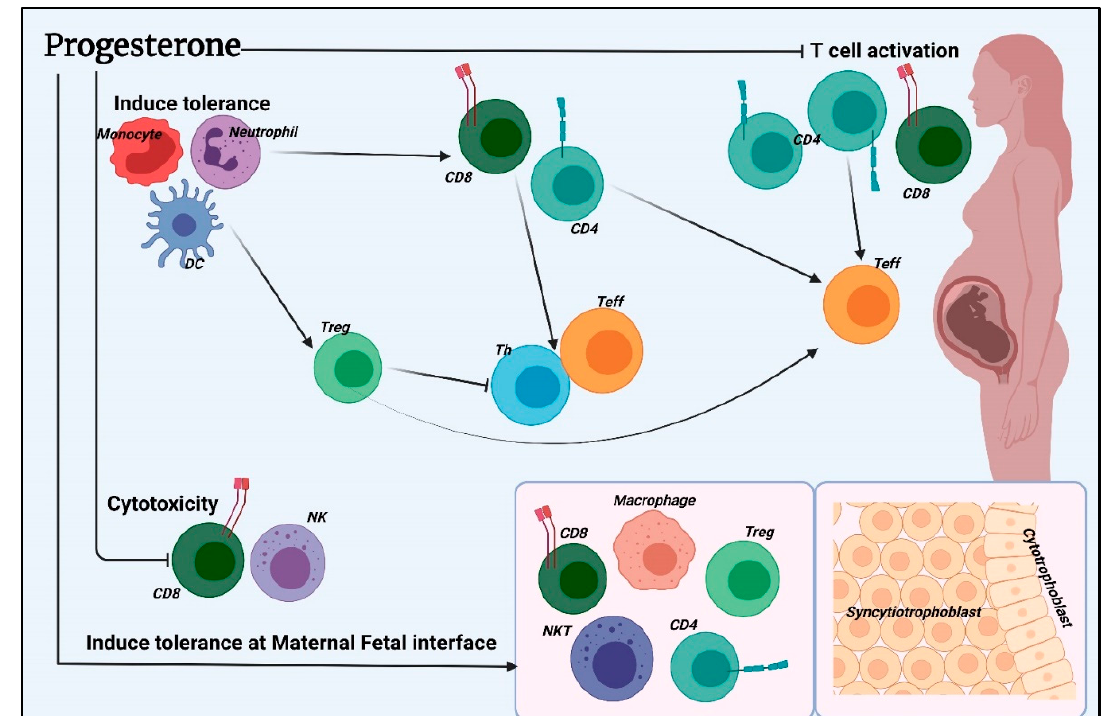
Figure 1. Summary of progesterone immunomodulatory mechanism. P4 directly influences T cell activation and differentiation by modulating TCR signal transduction or indirectly by generating tolerant antigen-presenting cells (APCs) such as dendritic cells (DC) that inhibit T cell activation during TCR interaction. P4 can also inhibit cellular cytotoxicity. P4 can promote placental tissue growth and invasion at the maternal-fetal interface by inducing immune-tolerant phenotypes of macrophages, natural killer (NK), and T regulatory (Treg) cells, as well as exhausting activated CD4 and CD8 T cells that have interacted with placental-derived fetal-paternal antigens. Chemoattractant molecules produced on placental tissue help these tolerant leukocytes migrate to maternal-fetal contact. Created with BioRender.com.